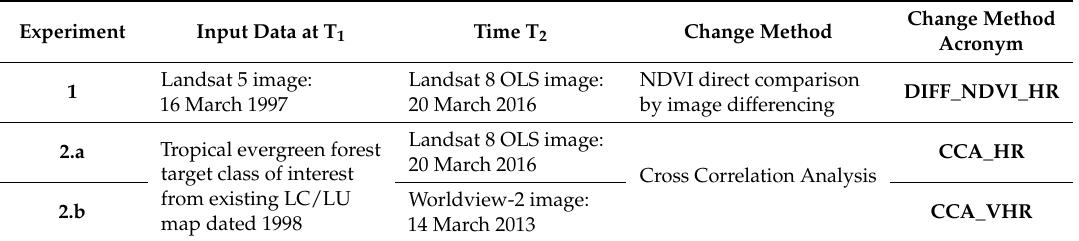
Table 2. Set of experiments and abbreviations used for the Indian